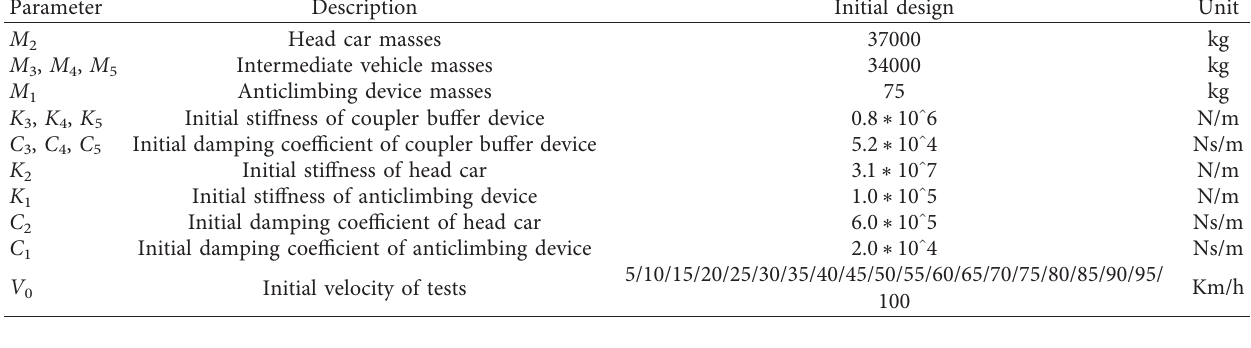
Table 1: Description of the train parameters.